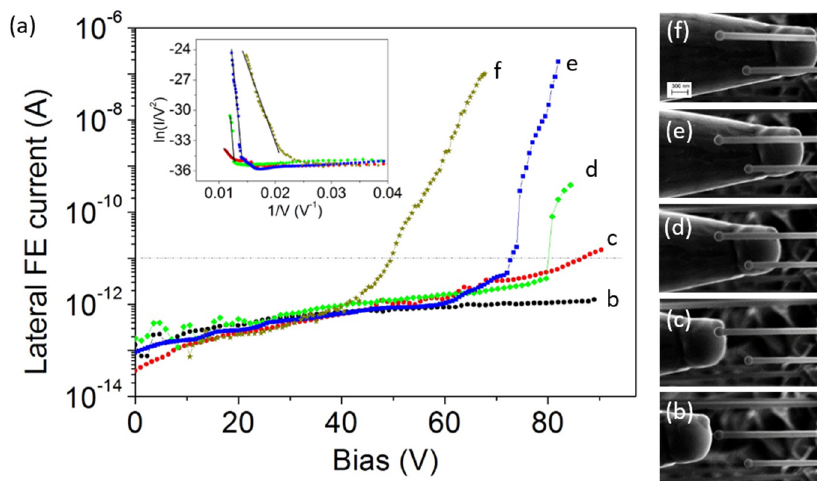
Figure 4. ( a ) I − V characteristics measured in the lateral FE configuration. Curves refer to the SEM images ( b – f ). Inset: FN plots and linear fits.